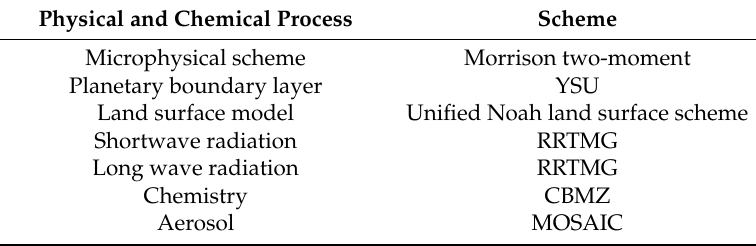
Table 1. Physical and chemical parameterization schemes employed in the